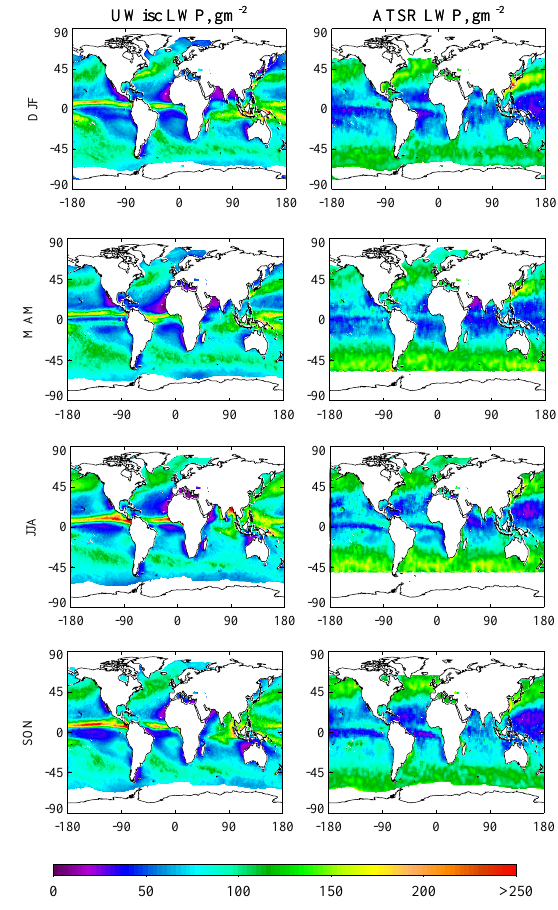
Fig. 17. Multiyear seasonal composites of cloud liquid water path for (top to bottom) DJF, MAM, JJA, and SON. The left shows maps from the UWisc microwave climatology of O’Dell et al. (2008) and those on the right are from the ATSR-2 GRAPE